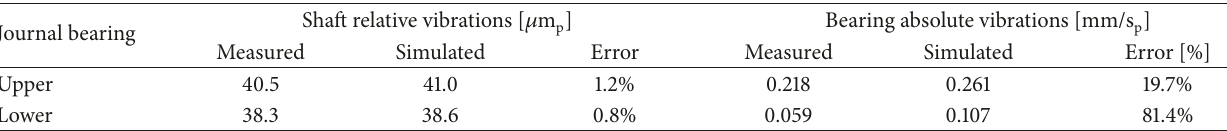
Table 8: Comparison of measured and simulated vibrations in 𝑋 direction, in an LHG operating at speed-no-load, with an unbalance grade ISO G4.25 in the generator rotor, at the rotating